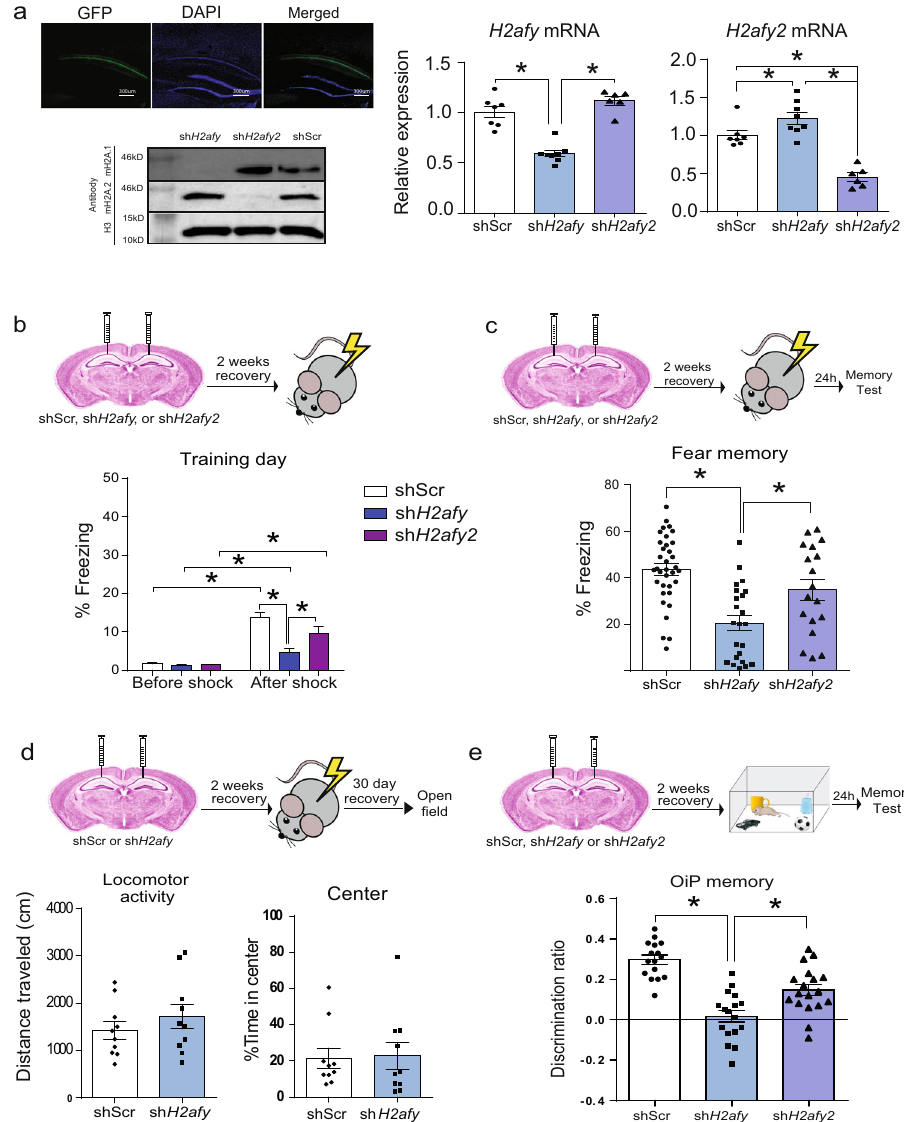
Fig. 1 Hippocampal depletion of mH2A1 impairs memory more than the depletion of mH2A2. a Validation of mH2A1 (encoded by H2afy gene) and mH2A2 (encoded by H2afy2 gene) depletion in the mouse hippocampus. b During the fear memory training session, all mice show increased freezing after receiving shock, suggesting that learning has occurred in all groups. c Depletion of mH2A1, but not of mH2A2, impairs recall of fear memory 24 h after training (N: shScr = 35, sh H2afy = 24, sh H2afy2 = 18). d mH2A1 depletion does not affect locomotor activity ( N = 10/group). e mH2A1 and mH2A2 depletion each impair memory for Object in Place, but the impairment is greater in mH2A-1 than in mH2A2-depleted mice (n: shScr = 16, sh H2afy = 17, sh H2afy2 = 18). Data are shown as mean ± SEM. (ns p > 0.05, * p <